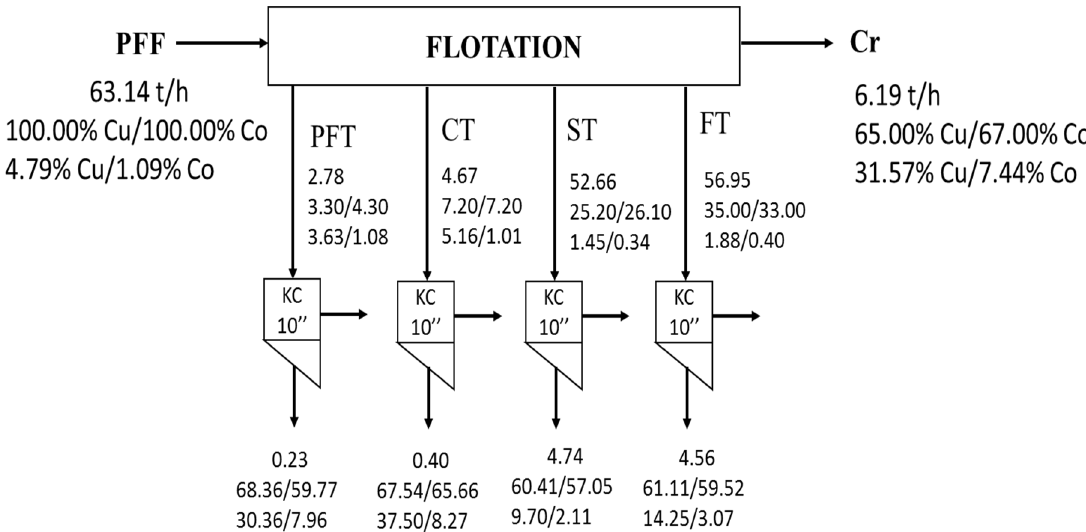
Figure 19. Schematic for the separate treatment of tailings (PFF: Pre-floated feed, PFT: Pre-float tails, CT: cleaning tails, ST: scavenger tails and FT: final tails) [20] .